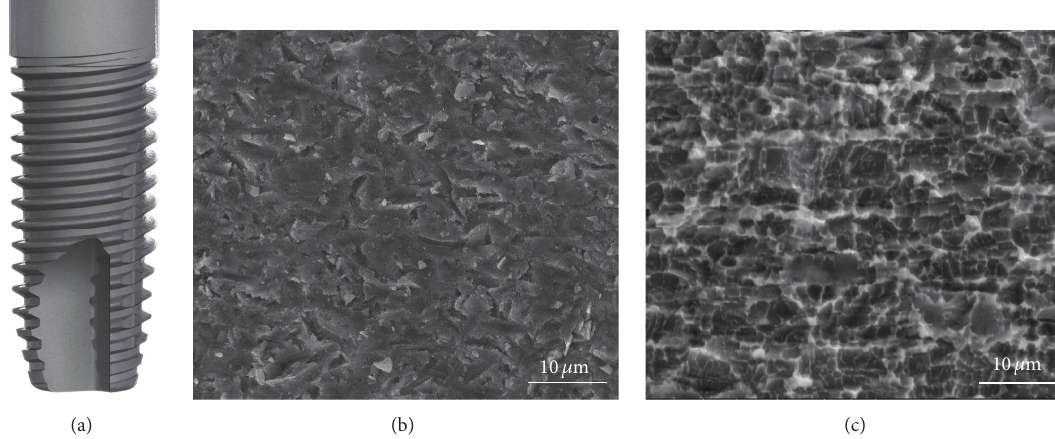
Figure 1: (a) Principal design of the Neoss implant. (b) Scanning electron micrograph (SEM) of bimodal surface in high magnification. (c) SEM of proactive implant in high